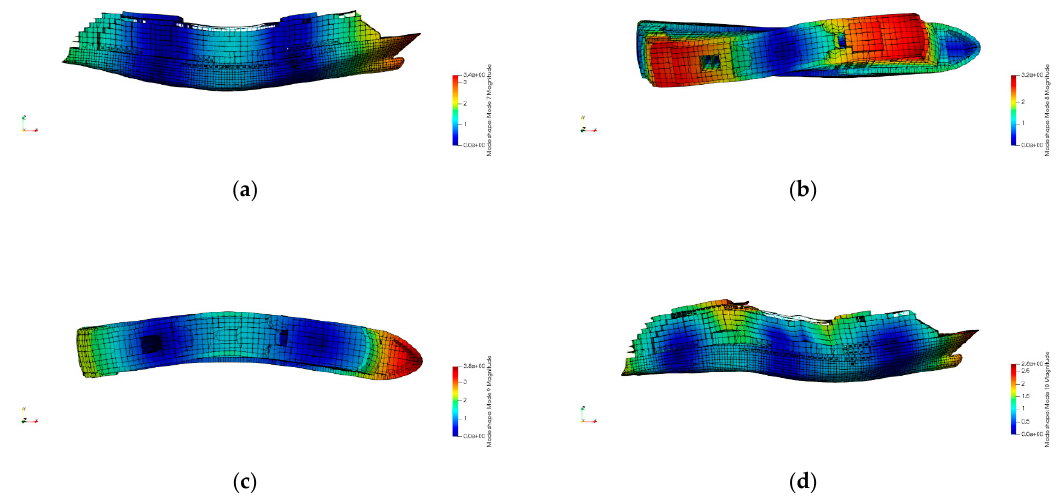
Figure 6. Dry mode shapes and eigenfrequencies. (a) 2-node VB mode at 12.56 rad/s ( b ) 1-node T+HB mode at 14.56 rad/s ( c ) 2-node HB+T mode at 14.92 rad/s ( d ) 3-node VB mode at 17.27 rad/s.